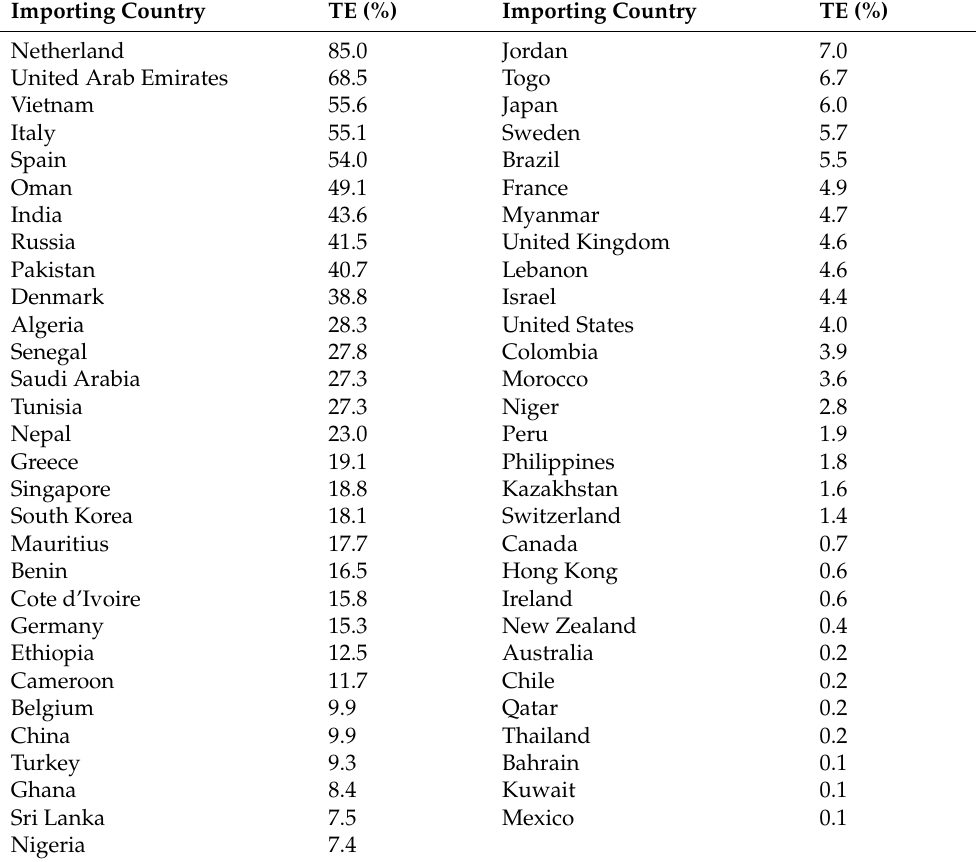
Table 5. Indonesia Palm Oil Export Technical Efficiency